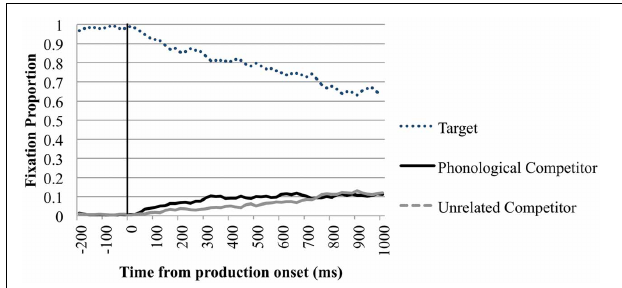
FIGURE 3 | Eye-movements in the phonological trials of the production condition. Proportion of fixations are sorted per quadrant and plotted as a function of time. Time point 0 is the speech onset, as indicated by the black